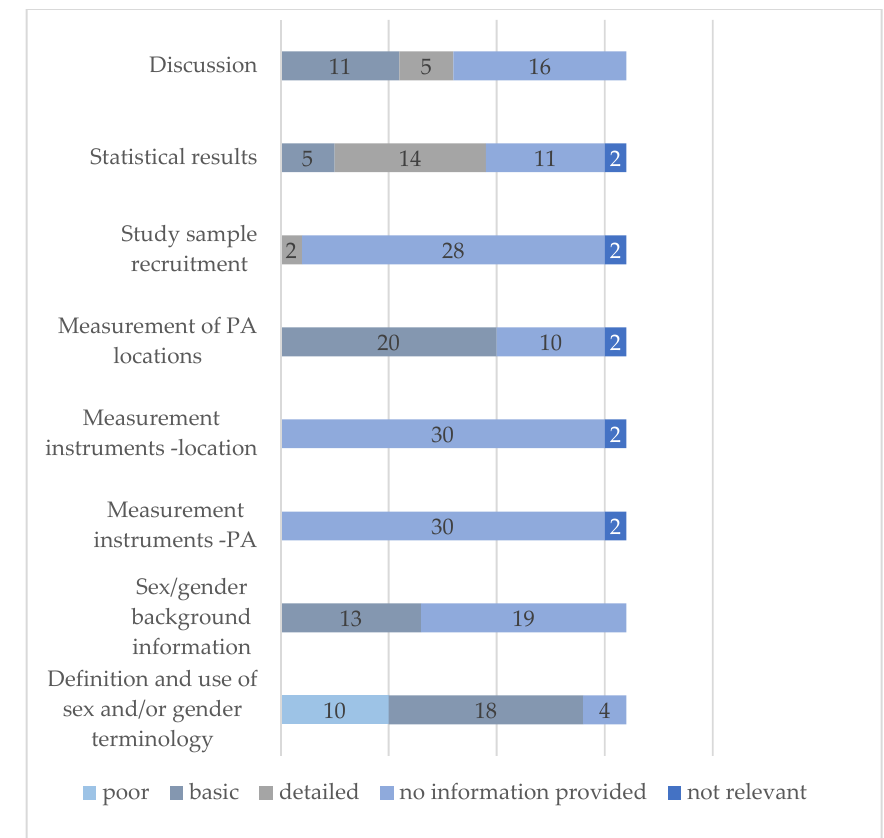
Figure 3. Analysis of the sex/gender checklist across studies. Note. Abbreviation: PA, physical activity.